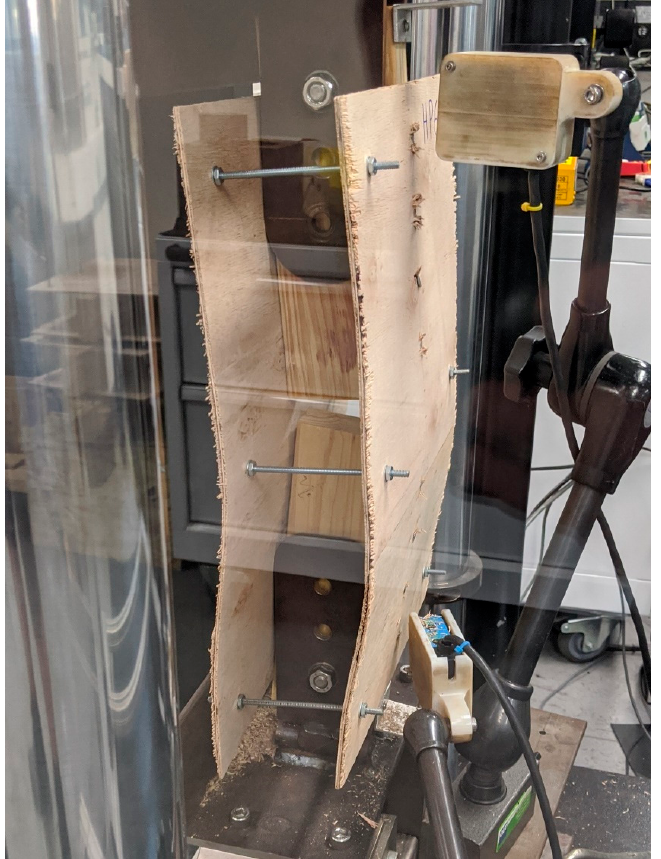
Figure 12. Boxplot comparisons of Southern Queensland pine (SQP) and spruce/pine/fir (SPF) STC specimens by normalised ( a ) peak load, ( b ) yield load, ( c ) stiffness, and ( d ) ductility.